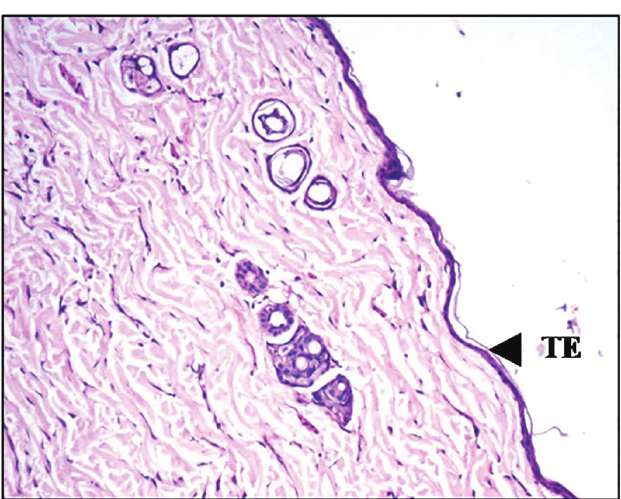
FIGURE 2 (I) - Photomicrograph of section of skin of neonate of pregnant rat exposed to pesticide carbendazim shows slight thinning of epidermis (TE) (H & E 100X).